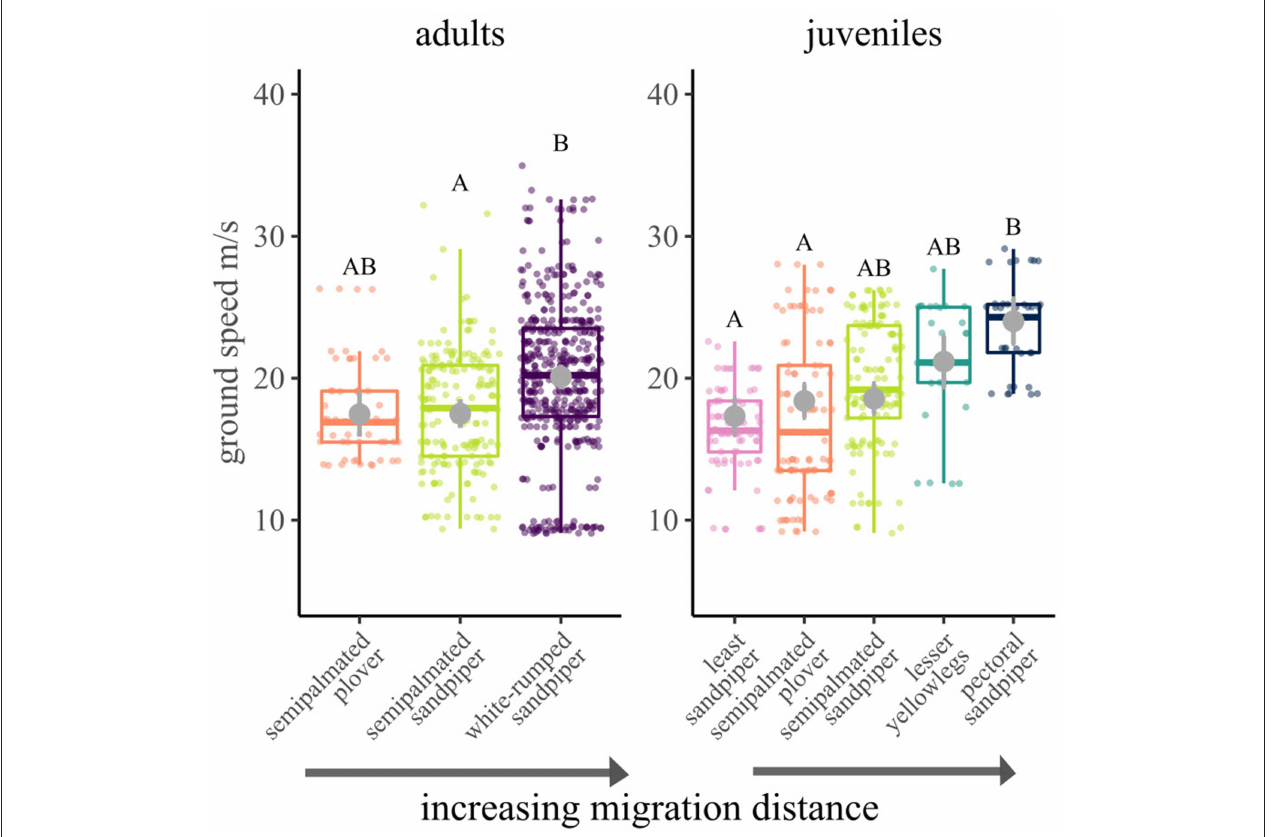
FIGURE 5 | Ground speeds for shorebirds migrating from James Bay, Ontario, Canada to the southern automated radio telemetry array. Boxplots were constructed from raw data, whereas gray circles and error bars show model predicted means and standard errors. Letters designate significant differences ( α = 0.05) for that age